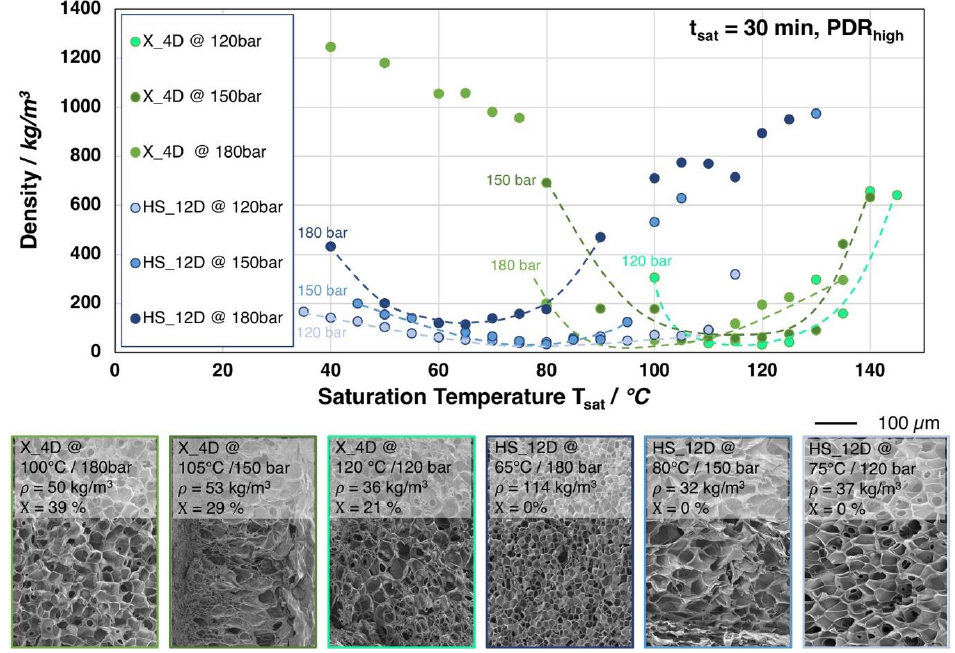
Figure 8. Top: Foam densities of the grades X_4D and HS_12D (with similar molecular weight but varying D-contents) foamed after 30 min. saturation with CO 2 at 120, 150, and 180 bar and varying temperatures. Bottom: SEM images of the foam with lowest density for both grades with crystallinity values (1 st heating).